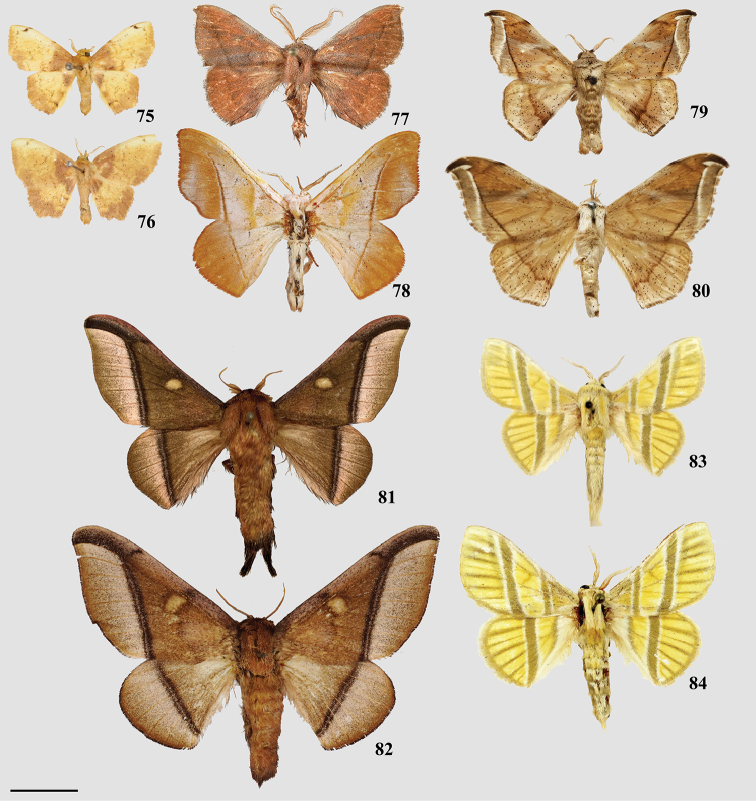
Adult specimens of type species of genera belonging to Zaphantinae, incertae sedis, and Aurorianinae. 75Zaphantainfantilis, male [photo A Giusti] (NHMUK) 76Z.infantilis, female [photo A Giusti] (NHMUK) 77Cunicumaraanae, paratype male [reused with permission St Laurent (2016), ZooKeys] (CDH) 78Aurorianacolombiana [reused with permission St Laurent and Mielke (2016), ZooKeys] (NHMUK) 79Menevialantona, male [reused with permission St Laurent and Dombroskie (2016), ZooKeys] (CUIC) 80M.lantona, female [adapted from St Laurent and Dombroskie (2016), ZooKeys; repaired in CS4] (USNM) 81Roelofaolivia, male (MWM) 82R.olivia, female [photo A Giusti] (NHMUK) 83Tolypidaamaryllis, male (MWM) 84T.amaryllis, female (MWM). Scale bar: 1 cm.